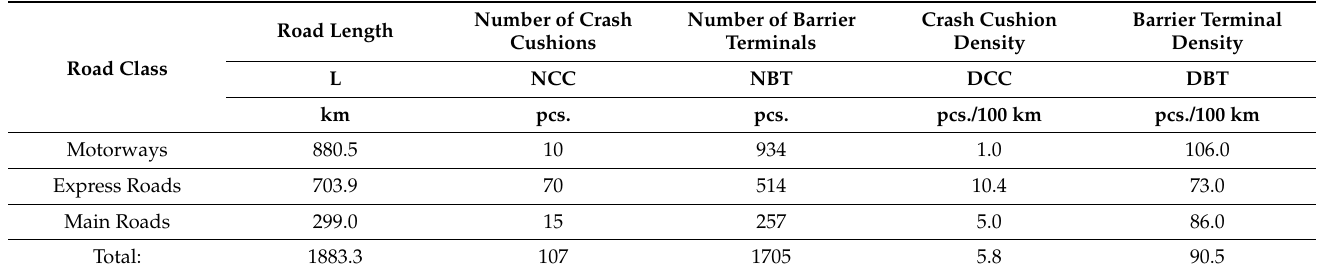
Table 1. Cushions and barrier end-terminals on sections of national